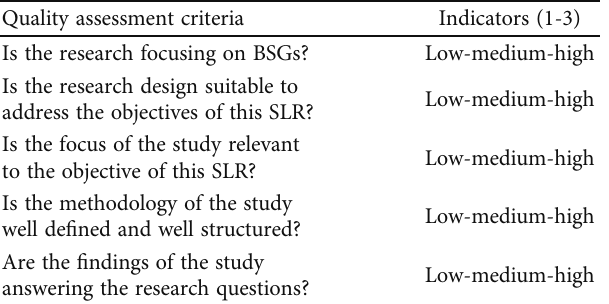
Table 3: Quality assessment